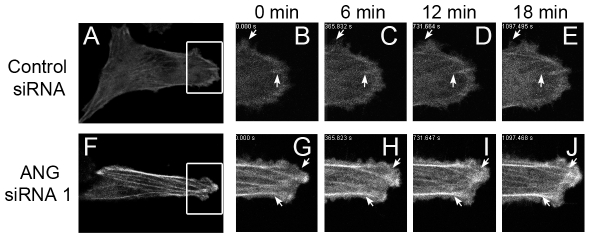
Down-regulation of ANG decreased the cytoskeleton dynamics in HeLa cells.HeLa cells were transfected with RFP-actin plus control siRNA or ANG siRNA. Fluorescence images were then taken at 2-min intervals for 18 min, and the images at 0 min, 6 min, 12 min and 18 min were shown. To qualitatively compare the position change of actin structure, two arrows were set at the fixed position in each set of images as a reference position. The upper arrow indicates growing pseudopodia, and the lower arrow points to stress fiber. (A) Representative fluorescence image of a HeLa cell transfected with RFP-actin and control siRNA. The images B–E magnify the boxed region in A at different time points. (F) Representative fluorescence image of a HeLa cell transfected with RFP-actin and ANG siRNA. The images G-J magnify the boxed region in F at different time points.